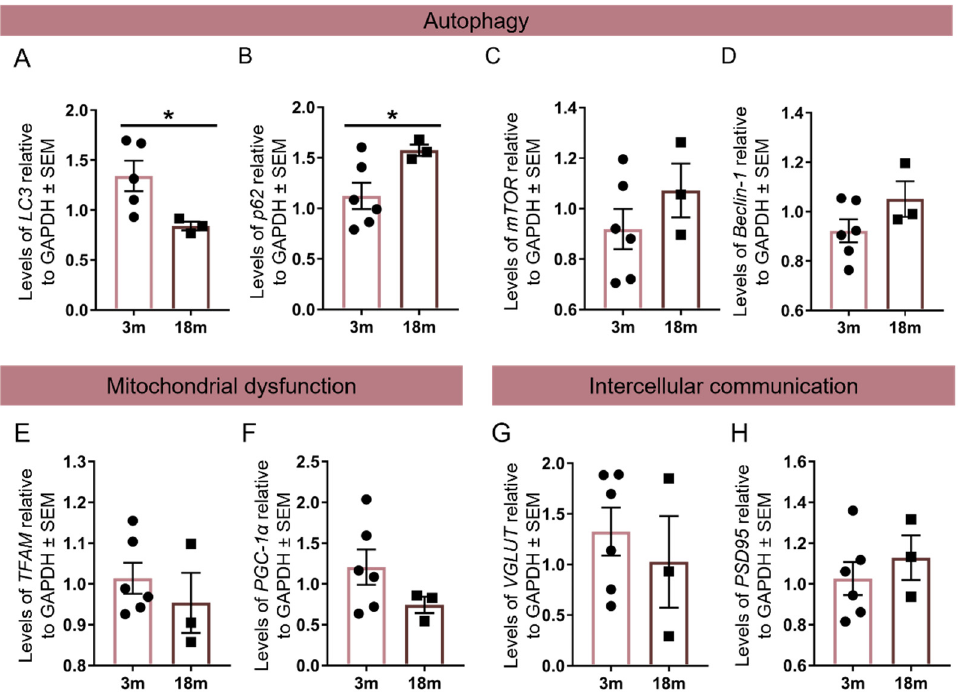
Figure 5. Assessment of aging hallmarks’ alteration upon MUTAtxn2 expression. mRNA relative levels in the striatum of SCA2 lentiviral mouse model, of 3 m ( n = 5–6) and 18 m ( n = 3) animals, twelve weeks post-injection. ( A – D ) Autophagy markers LC3, p62, mTOR, and beclin-1 were eval- uated. LC3 levels were significantly decreased in the 18m group compared with the 3m group. (E, F ) Mitochondrial dysfunctional markers evaluated were TFAM and PGC-1 α . (G, H ) Inter- neuronal communication markers VGLUT and PSD95 were evaluated in the 3m and 18m animal groups. No difference was found in these markers. Values are expressed ± SEM (standard error of the mean) (unpaired t -test with Welch’s correction, * p < 0.05).